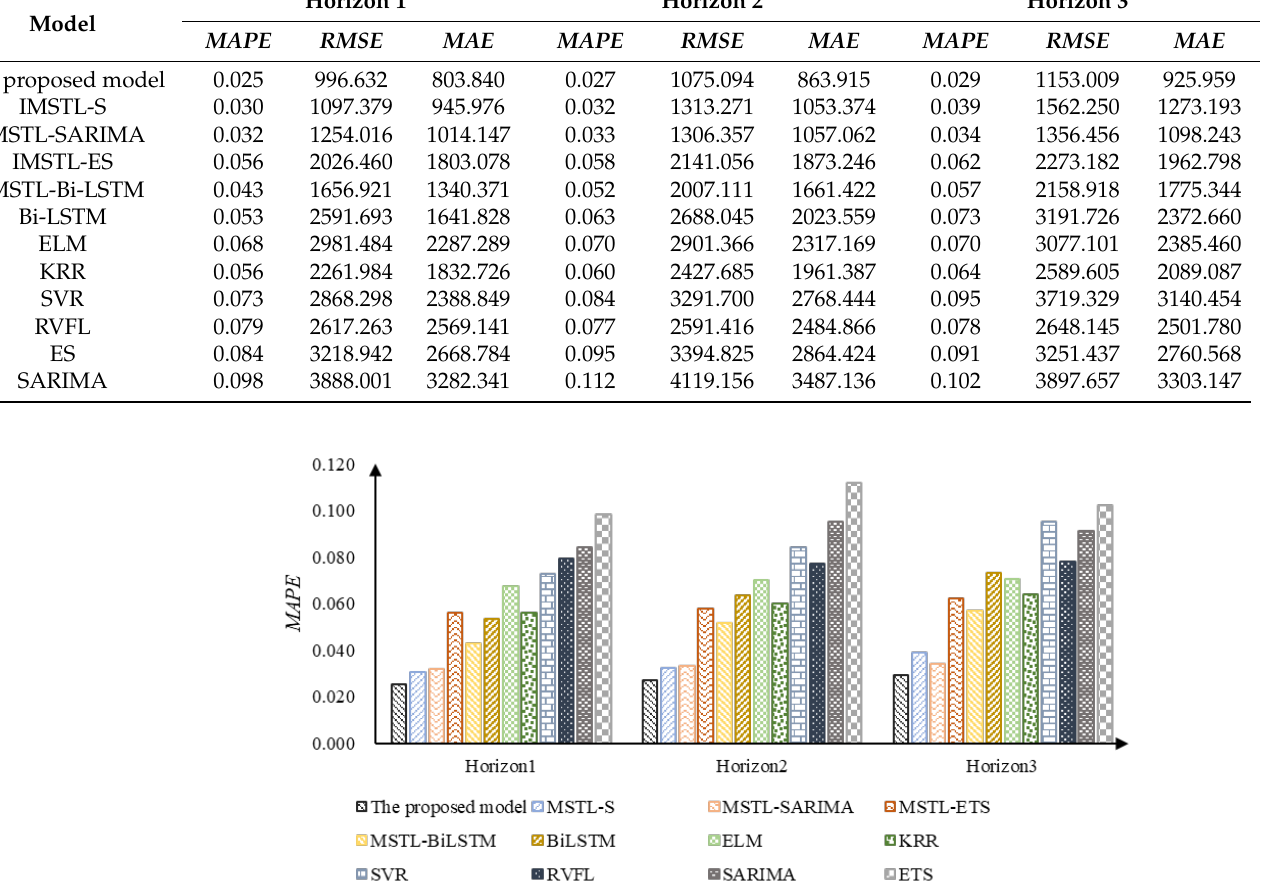
Figure 6. MAPE of each model in multi-step-ahead forecasting.